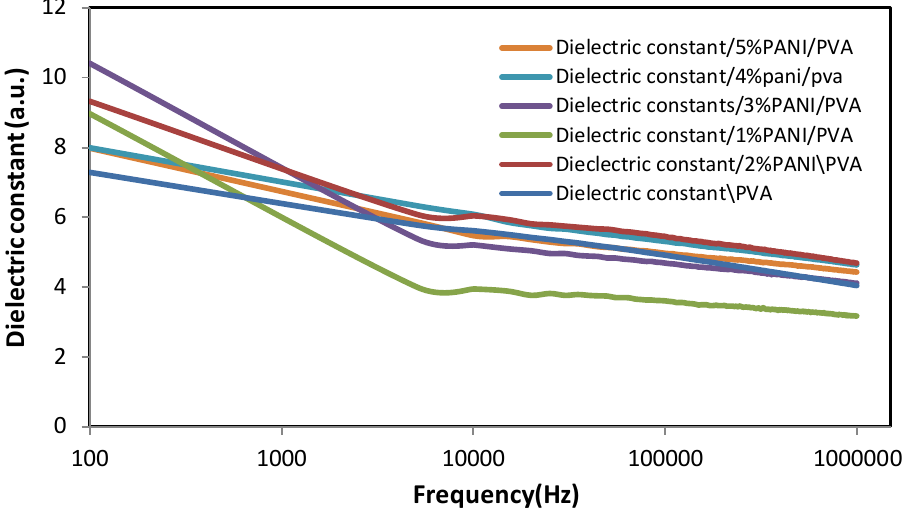
Figure 4: Dielectric constant as a function of frequencies for PVA before and after PANI addition.